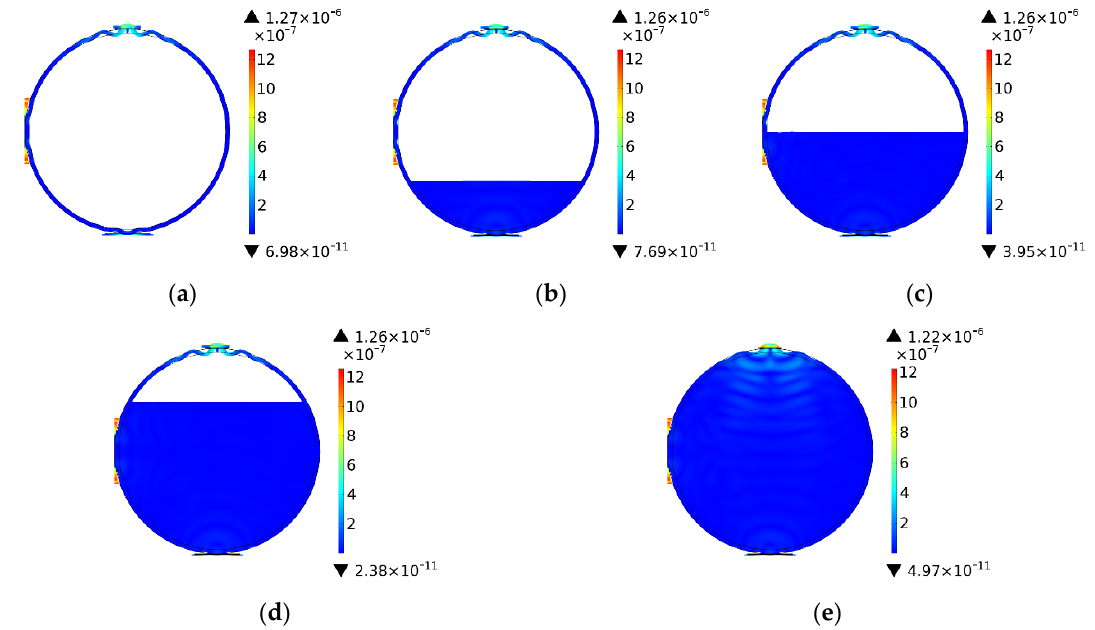
Figure 15. The structural deformation excited by PZT patches at frequency P3 (unit: mm). ( a ) Empty; ( b ) 25%; ( c ) 50%; ( d ) 75%; ( e ) 100%.